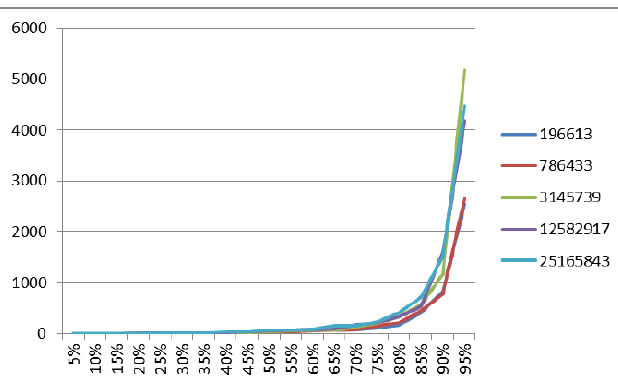
Fig. 10. Max collisions for Murmur, linear probing, string